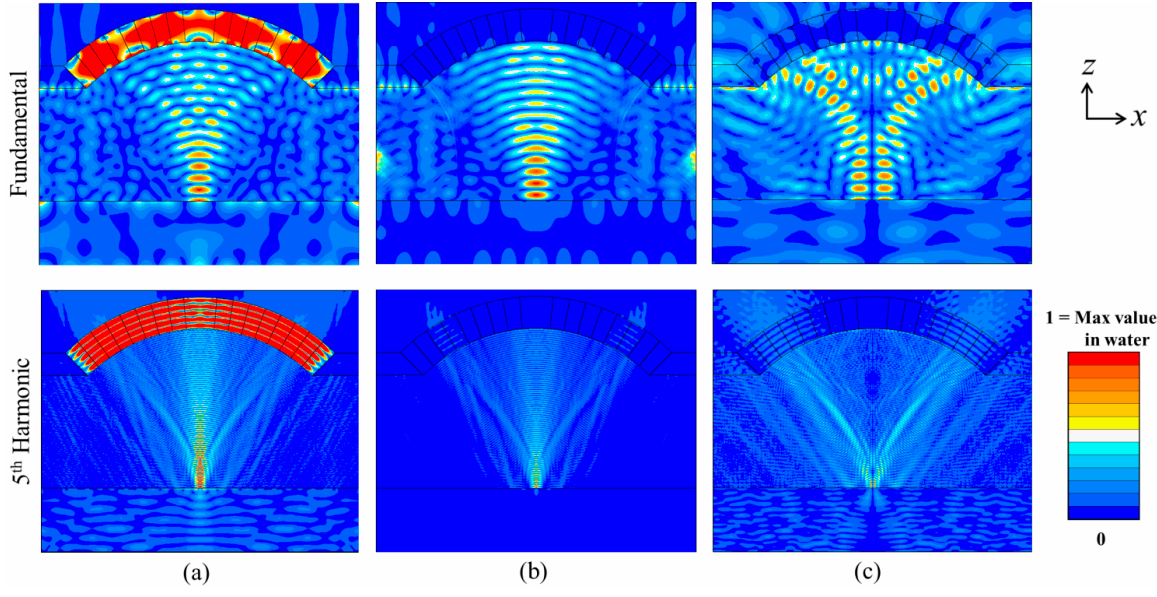
Figure 6. Normalised ( a ) pressure, ( b ) Z -velocity and ( c ) X -velocity fields of the curved ultrasonic resonator at the fundamental and 5th harmonic resonant